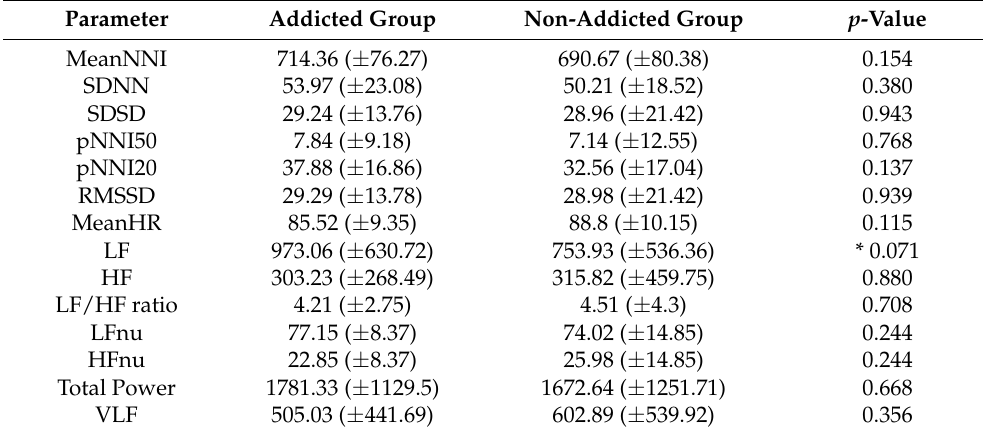
Table 4. The t -test results for data from 60 s window size after “killed event”; mean ( ± standard deviation).